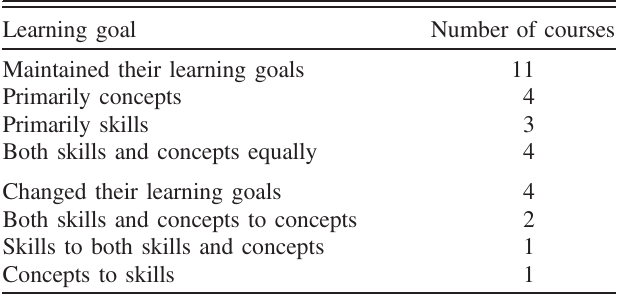
TABLE II. Learning goals of courses that found simulations to be